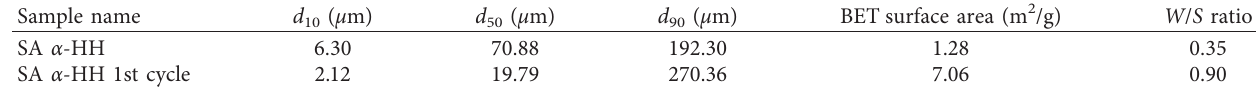
Figure 7: SEM images for dihydrate crystals formation from β -HH and β -HH after the first cycle. Table 3: Physical properties of pure SA α -HH and SA α -HH after the first cycle.